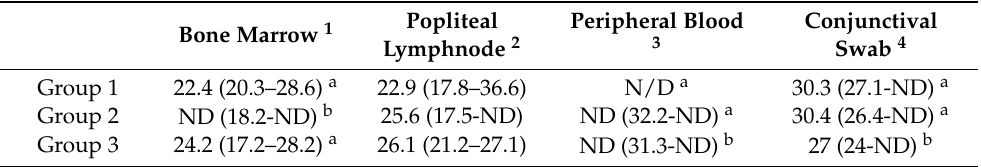
Table 3. TaqMan-qPCR results in the different biological samples studied according to clinical signs classification.